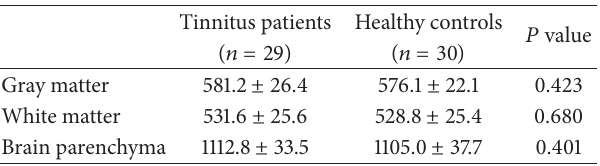
Table 2: Comparisons of the brain volumes between the tinnitus patients and healthy